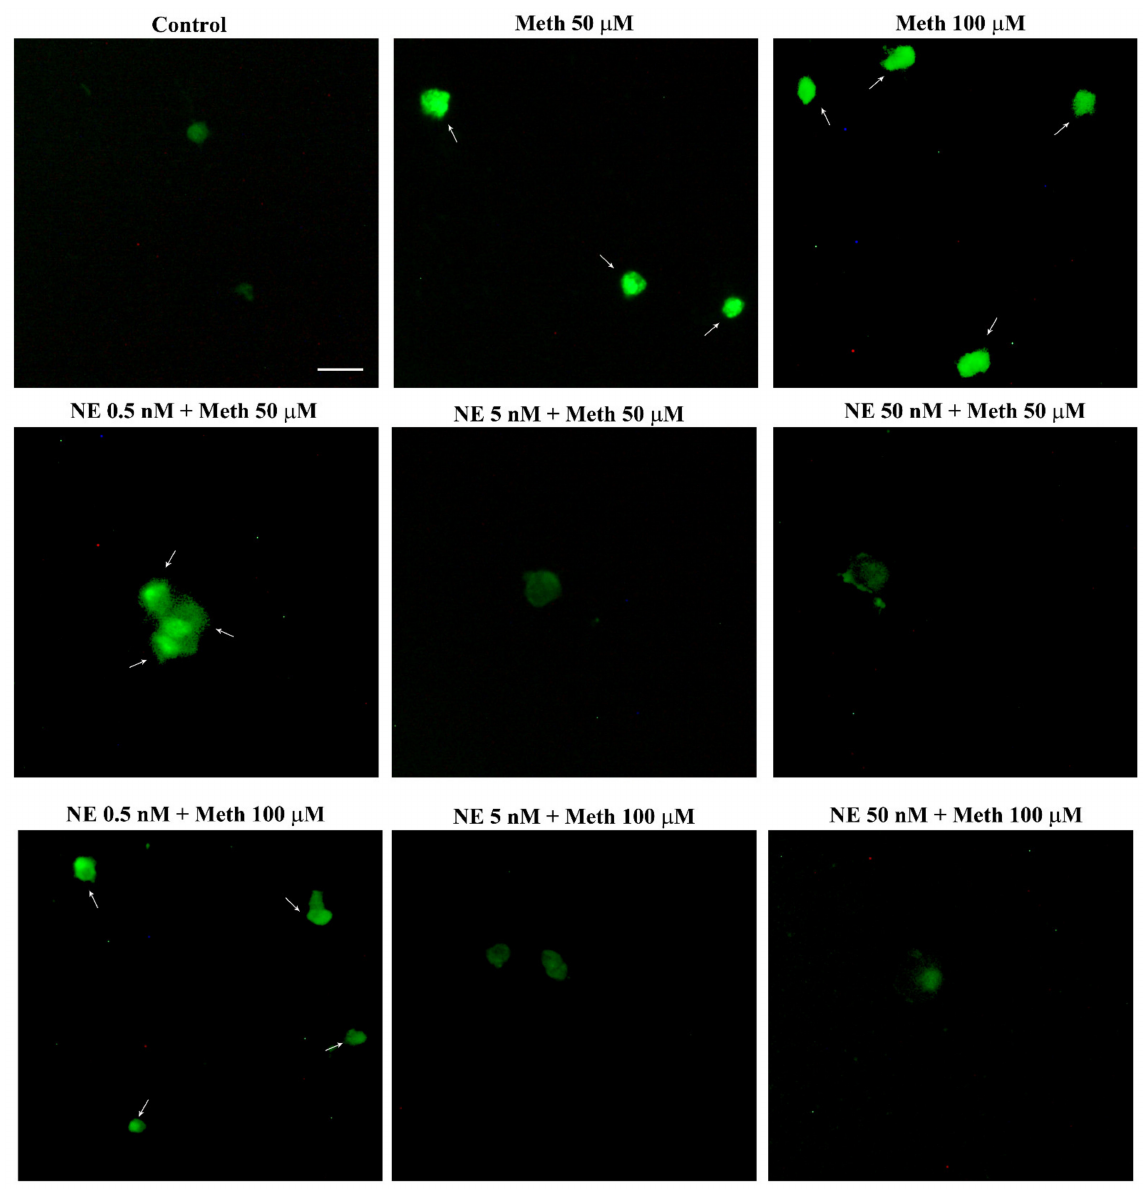
Figure 3. NE does protect against Meth toxicity (FJB staining). Representative pictures show NE protection against Meth- induced toxicity. The protective effects of NE are evident both at the dose of 5 nM and 50 nM, when administered to cells treated with Meth either at the dose of 50 µ M or 100 µ M. The toxicity induced by Meth is shown by intensely fluorescent spared cells (arrows). The protective effects of NE bring back the fluorescence to a pale signal as detected in Controls. Scale bar = 20 µ